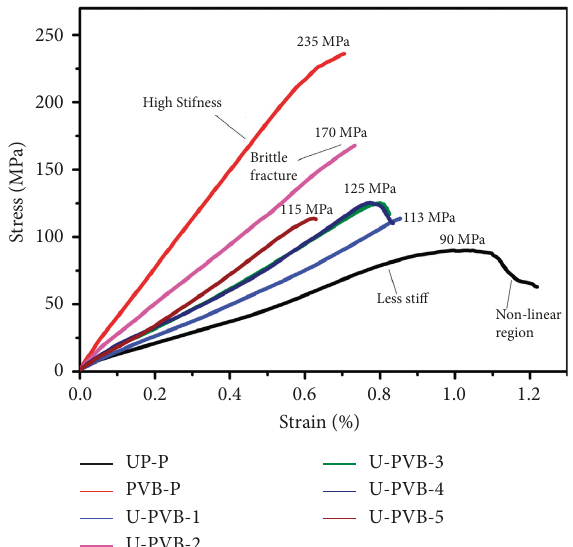
Figure 3: Stress-strain curves of test samples showing the behavior of pure and blended resin